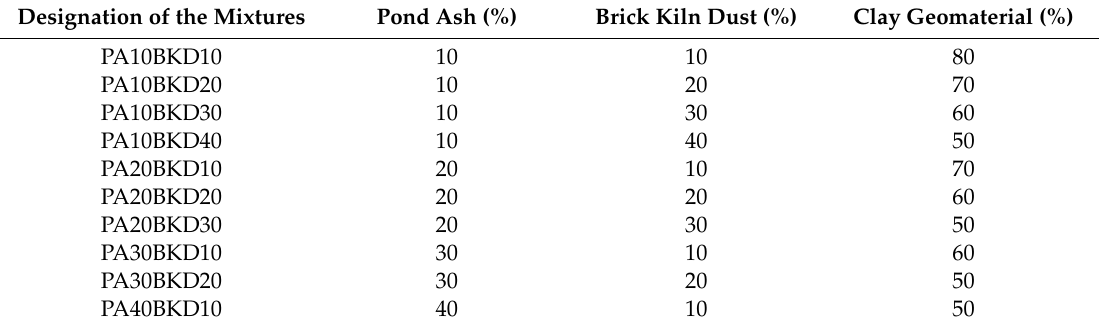
Table 2. Mix proportions for the geomaterial stabilized with combinations of waste.